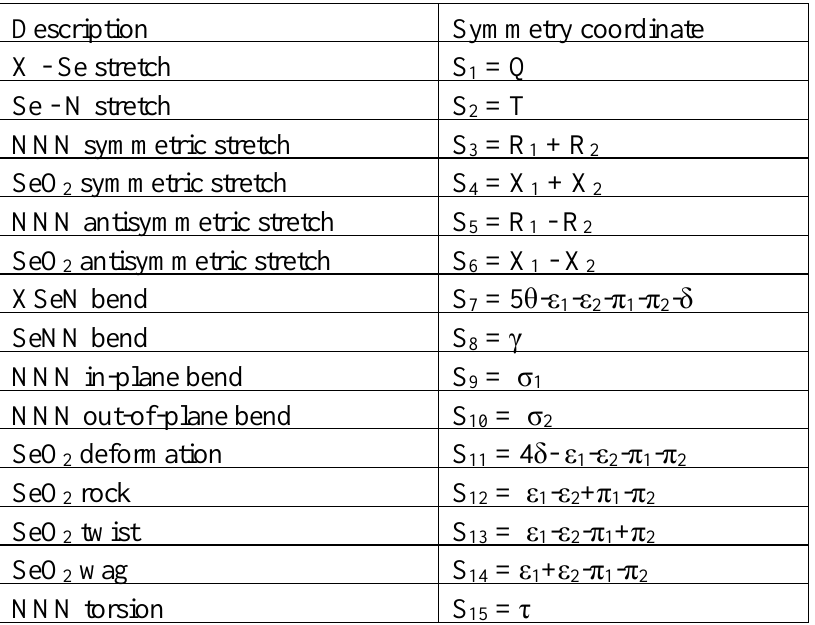
Table 4 : Symmetry coordinate definitions (all of them are of species A) for gauche halo- selenonyl azides (not normalized).